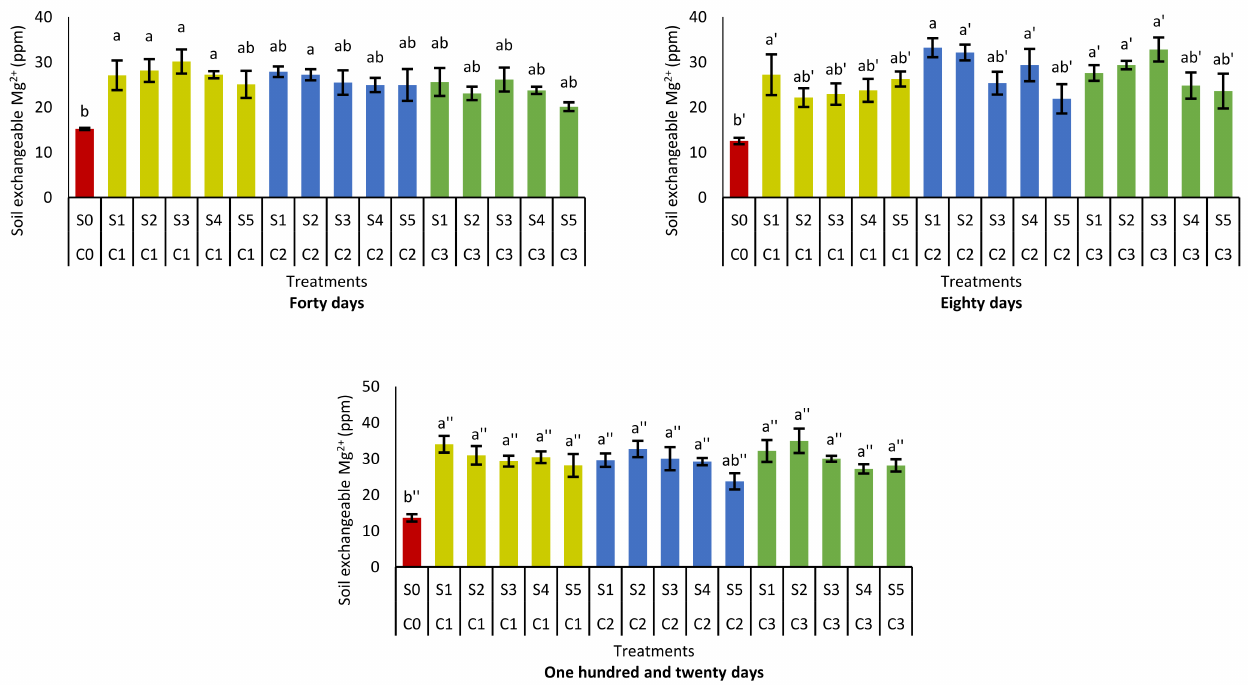
Figure 3. Soil exchangeable magnesium in relation to combined use of Calciprill and sodium silicate at forty, eighty, and one hundred and twenty days incubation. Different letters indicate significant mean differences using Tukey’s HSD test at p ≤ 0.05. The error bars refer to ± standard error of three replicates. Small letters, small letters with ’, and small letters with ” indicate mean comparison at forty, eighty, and one hundred and twenty days incubation, respectively.